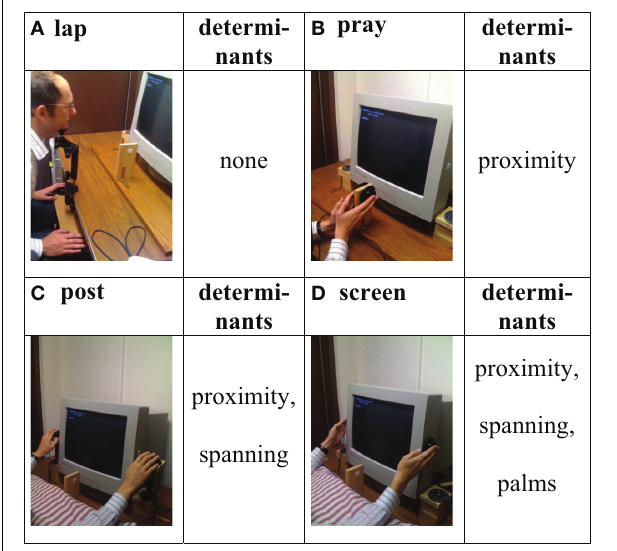
FIGURE 2 | Hand postures used in Experiment 1, labels for the hand postures, and determinants instantiated by the posture: (A) lap posture, (B) pray posture, (C) post posture, and (D) screen